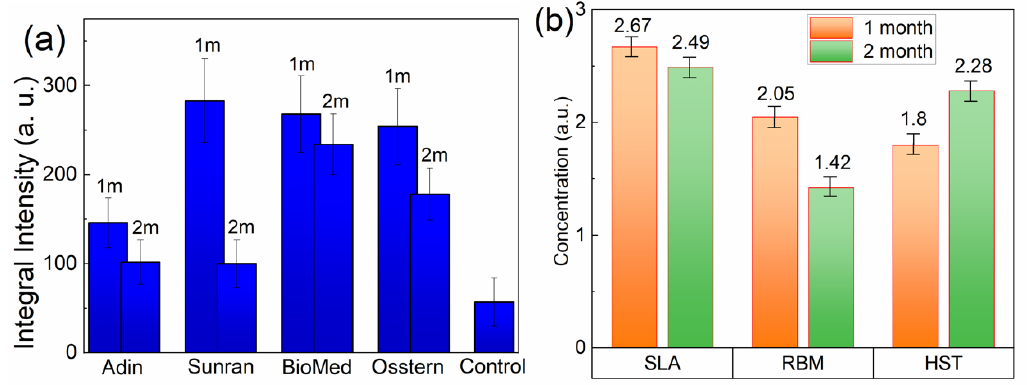
Figure 4. ( a ) Integral EPR intensities of carbonate paramagnetic centers in bone tissue samples adjacent to implants after 1 (1 m) and 2 (2 m) months compared to the control material; ( b ) Comparison of the EPR integral intensities for different types of surface microstructures of the Sunran implant after 1 (orange) and 2 (green) months after implant installation.